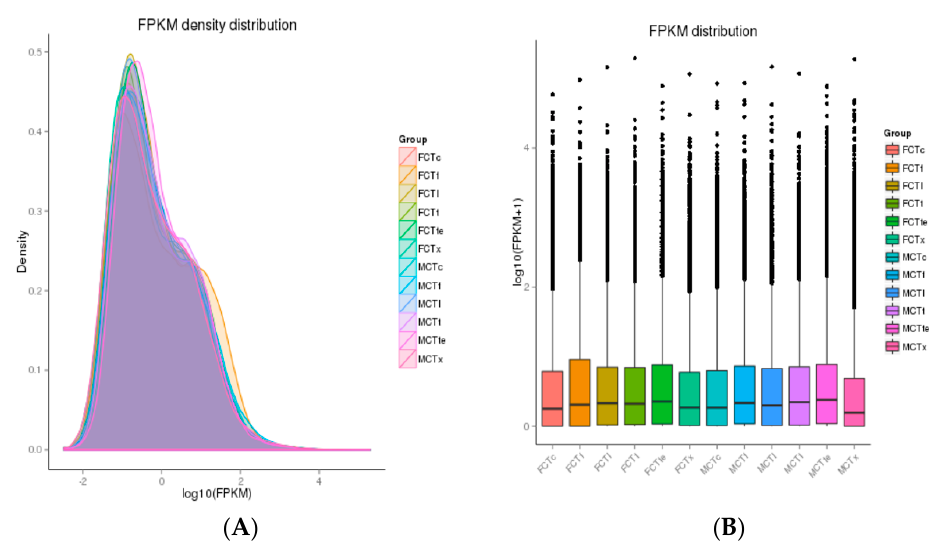
Figure 4. ( A ) The transcript FPKM density for each of the female and male samples. ( B ) The box chart presentation of different female and male sample expression levels.